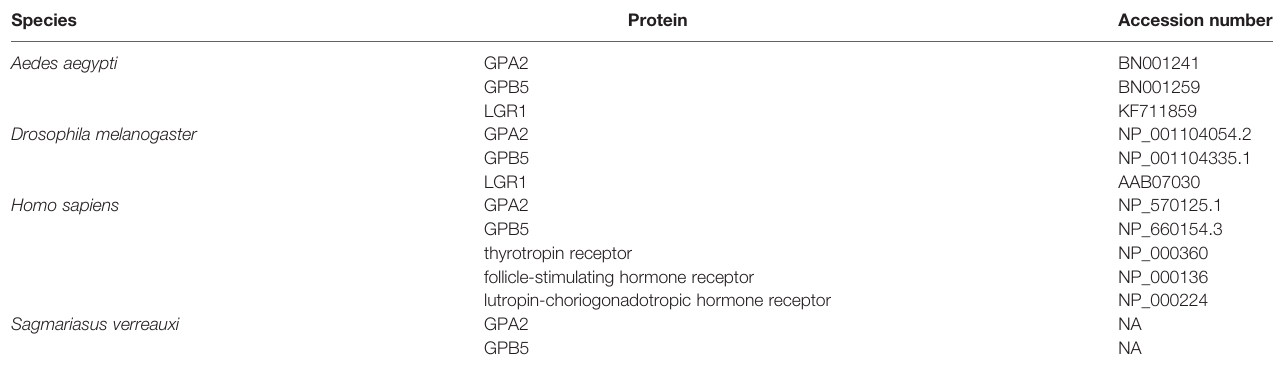
TABLE 1 | Proteins used for sequence alignments. Species